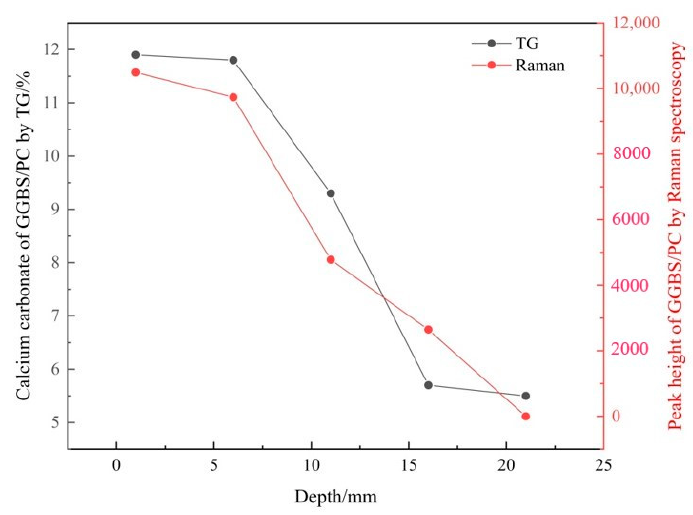
Figure 10. Carbonation profiles of the carbonated GGBS/PC paste samples established by Raman spectroscopy and TG